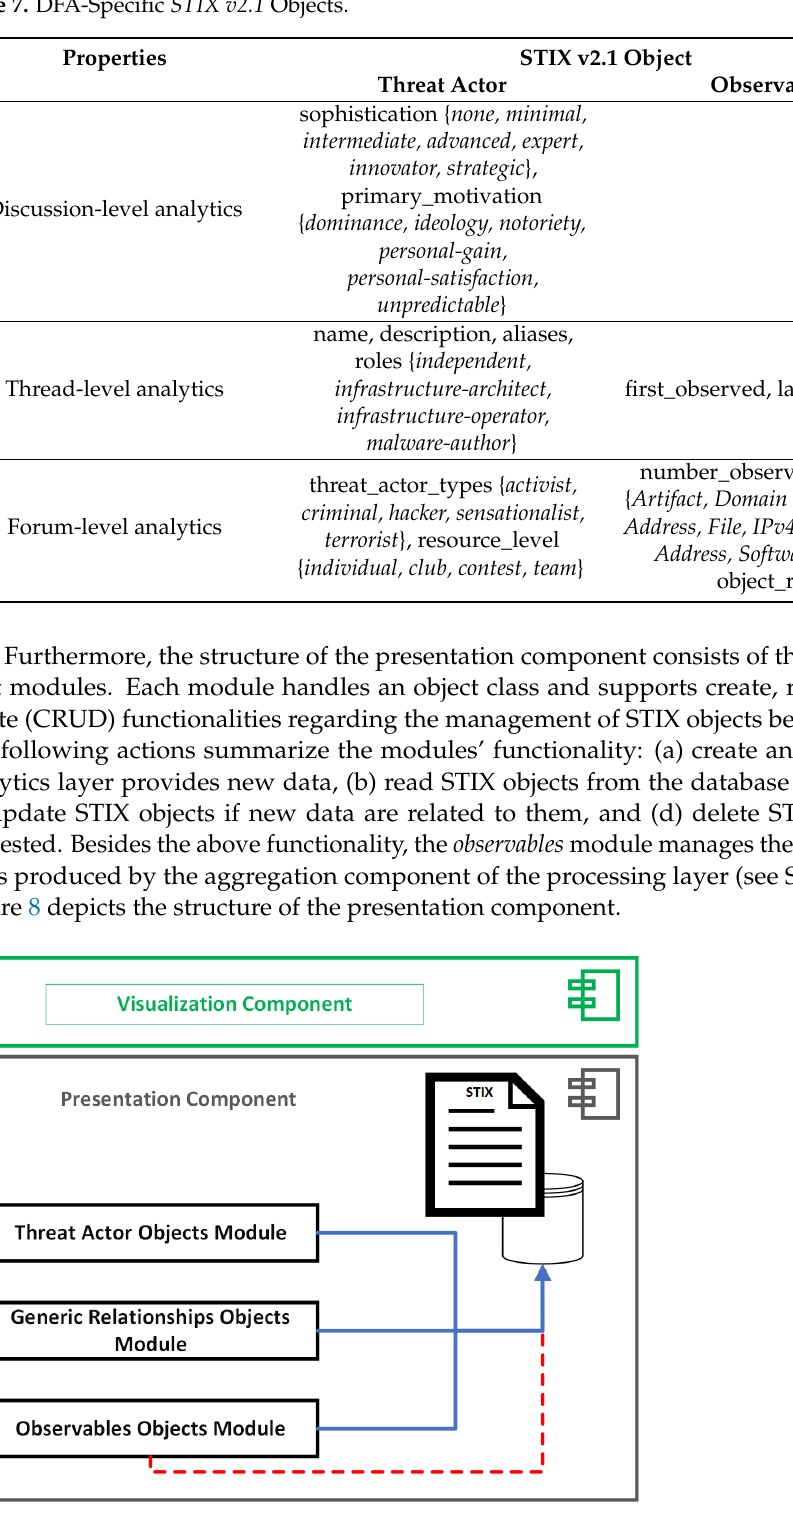
Figure 8. SECDFAN Presentation Layer